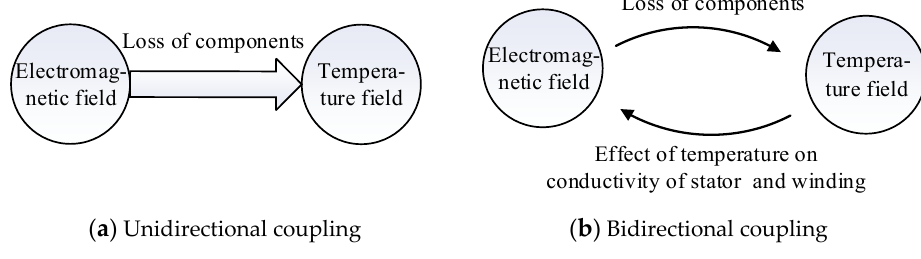
Figure 7. Coupling methods.